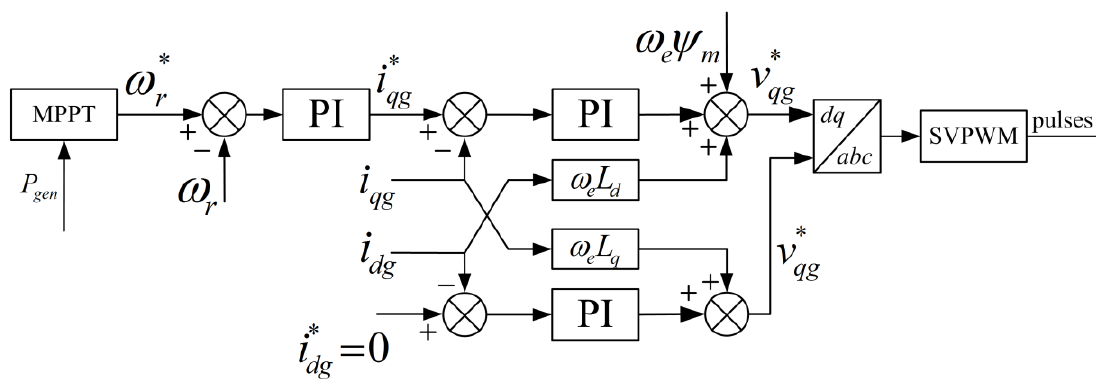
Figure 3. Control strategy of the generator side